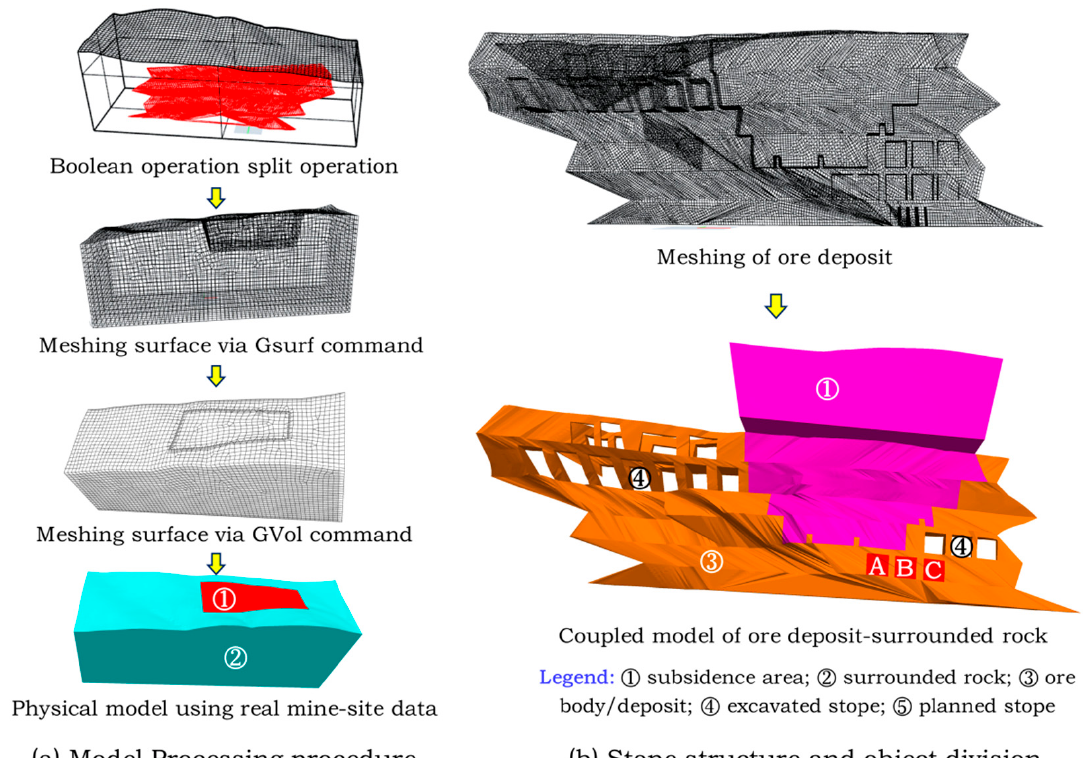
Figure 2. Coupled model processing procedure using Hongling mine-site data, Rhino 3D and FlAC 3D .